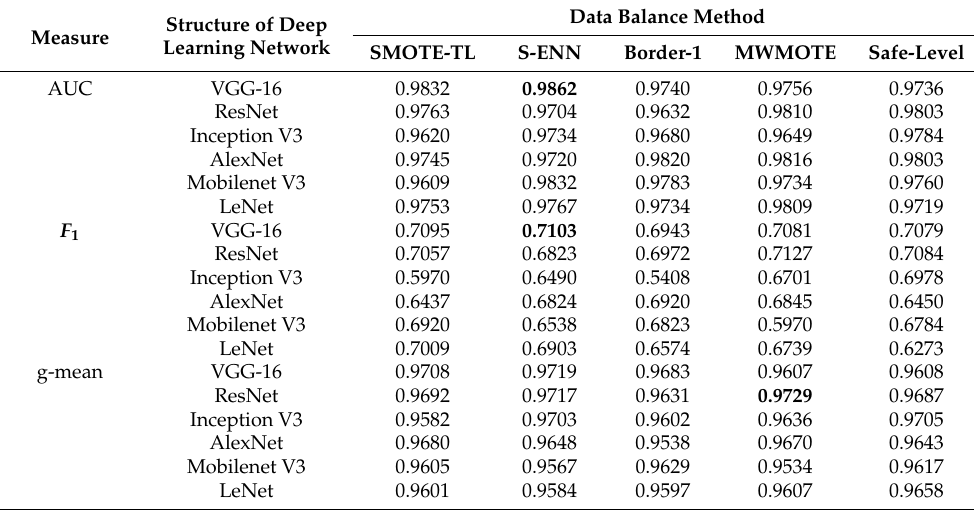
Table 6. Results of various combination of deep learning network structures and data balance methods.